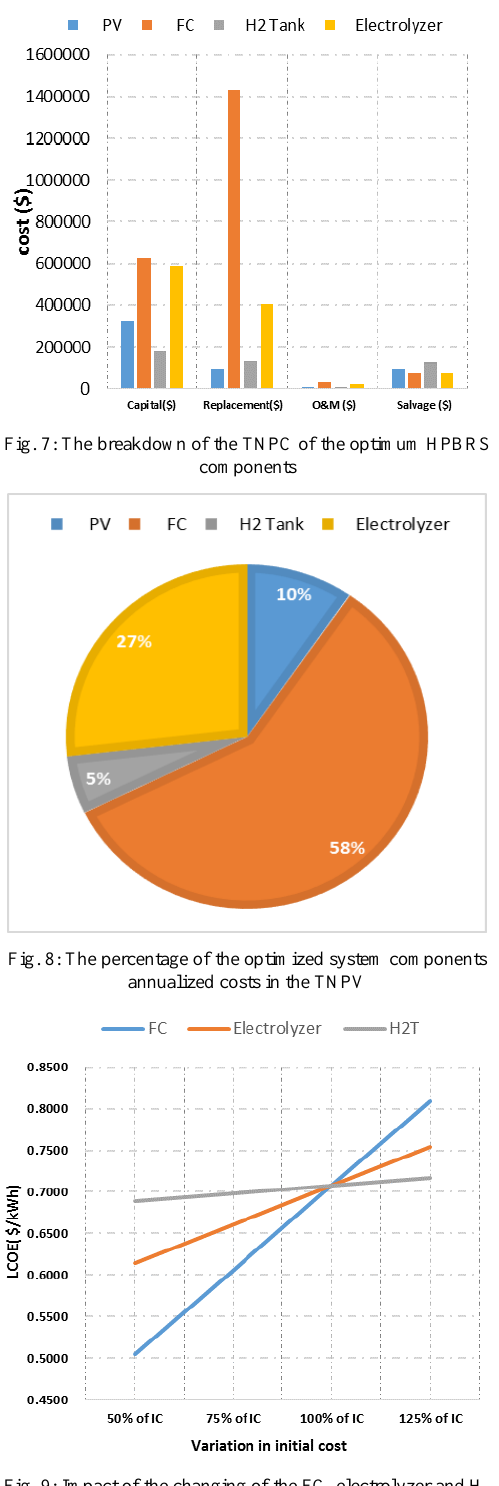
Fig. 9: Impact of the changing of the FC, electrolyzer and H 2 tank cost on the LCOE of the